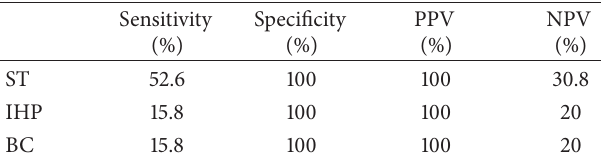
Table 3: Measures of test performance for BC, ST, and IHP against a constructed gold standard. PPV = positive predictive value, NPV = negative predictive value, ST = SepsiTest, IHP = in-house PCR, and BC = blood